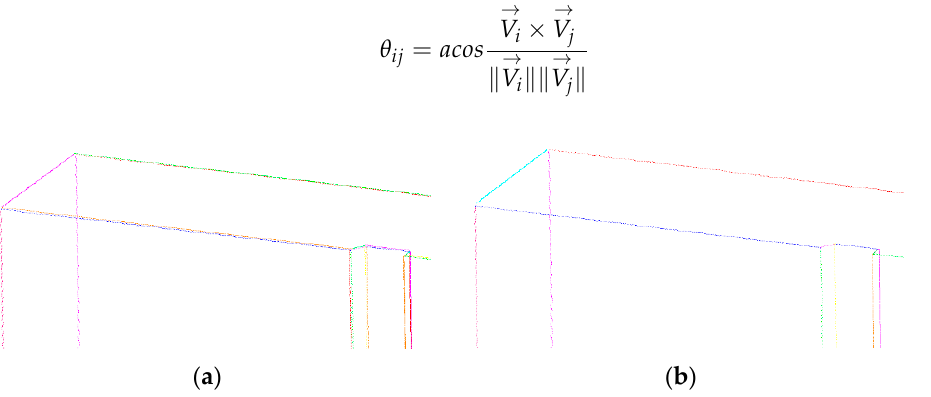
Figure 11. Comparison of 3D line segments before and after merging. ( a ) Before merging. ( b ) After merging. ( b ) After